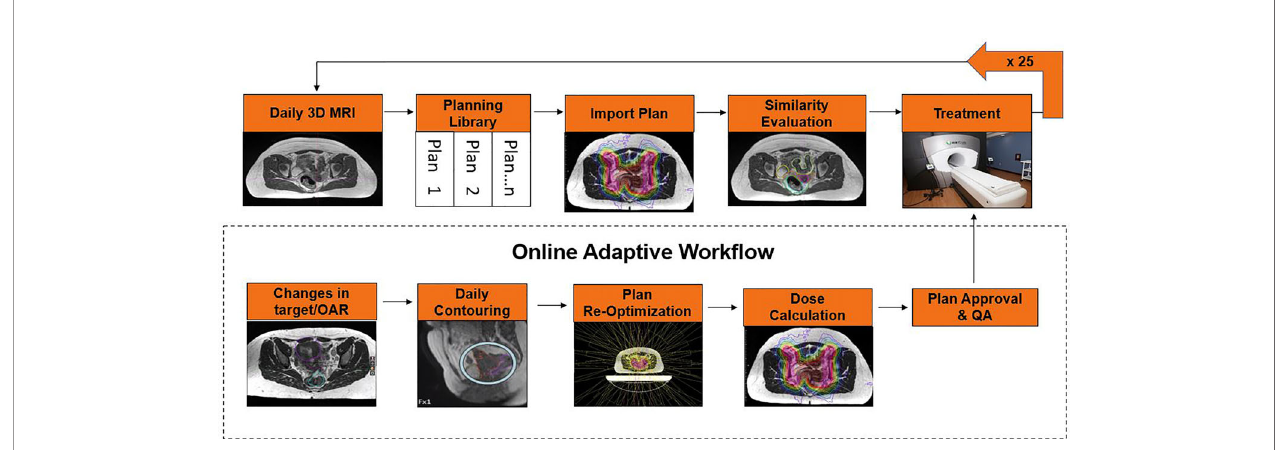
FIGURE 1 | POTD approach for oMRgRT for